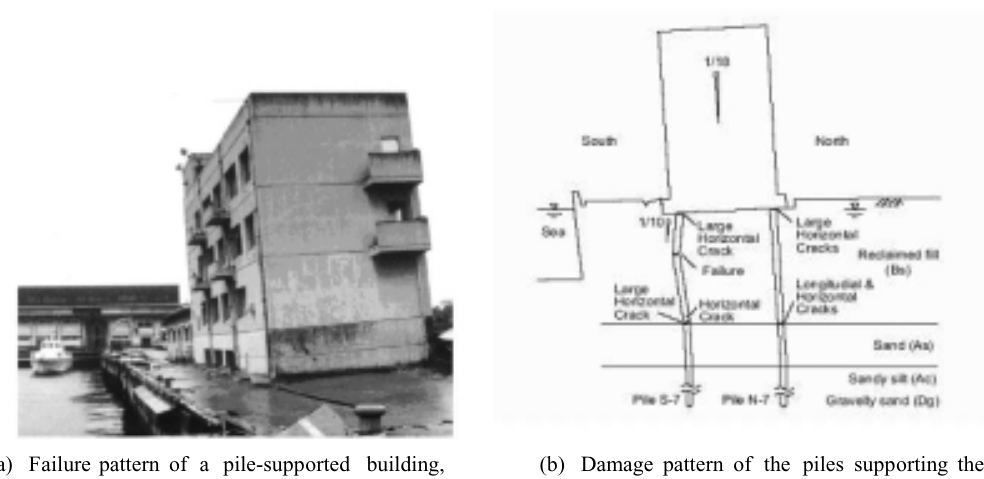
Fig. 1. The collapse of a building supported on 38 piles in the Higashinada-ku area of Kobe